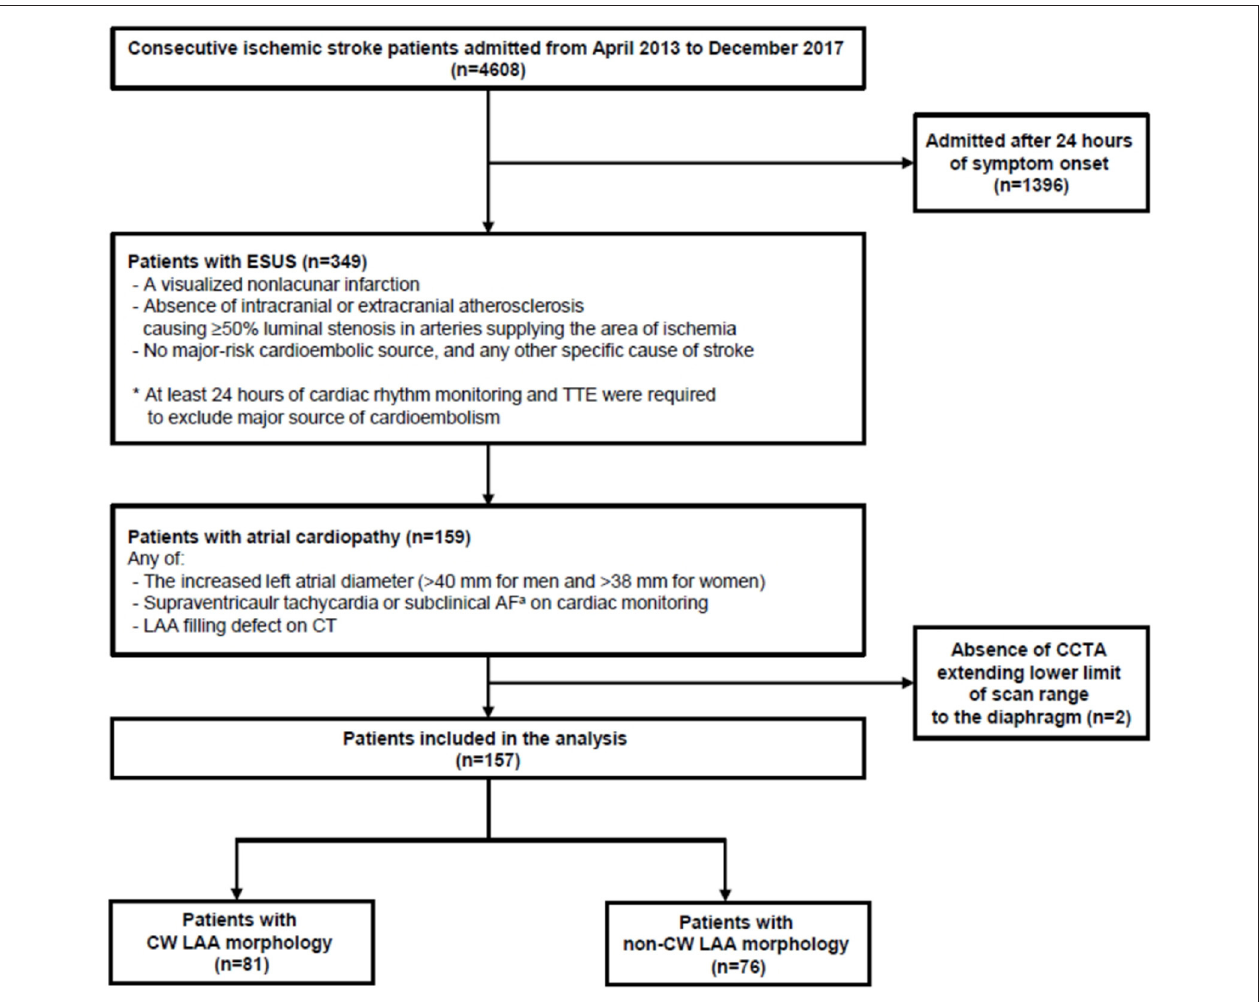
FIGURE 1 | Flowchart of patient screening and enrollment. ESUS, embolic stroke of undetermined source; TTE, transthoracic echocardiography; AF, atrial fibrillation; LAA, left atrial appendage; CT, computed tomography. a Defined as atrial fibrillation for <